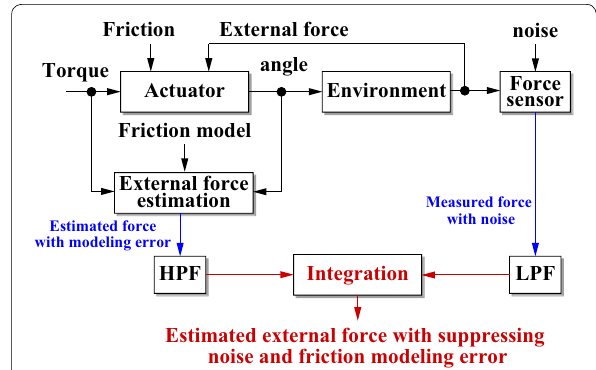
Fig. 1 Conceptual figure of the proposed